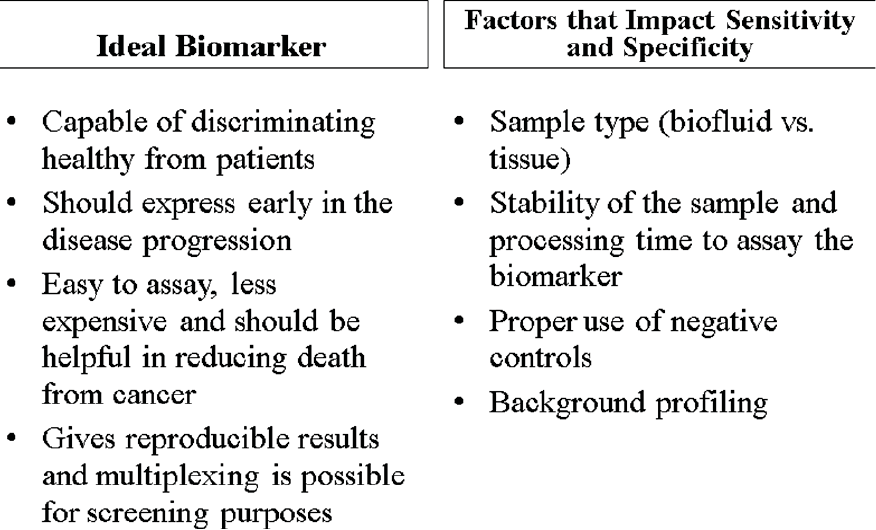
Figure 2. Characteristics of an ideal biomarker and factors influencing sensitivity and specificity of